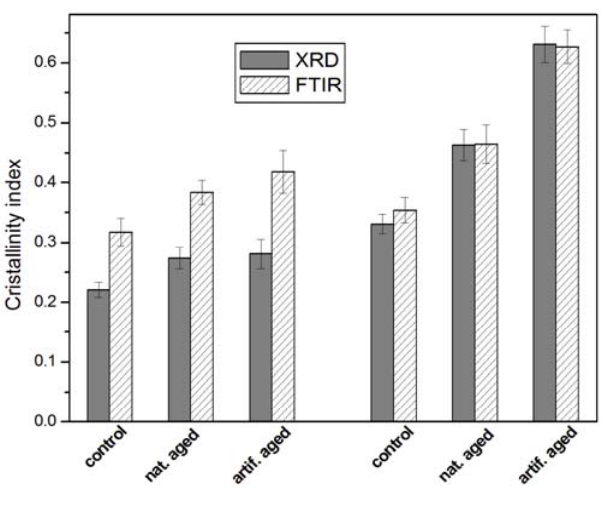
Figure 6. Crystallinity index (CI) of wood cellulose determined by XRD and